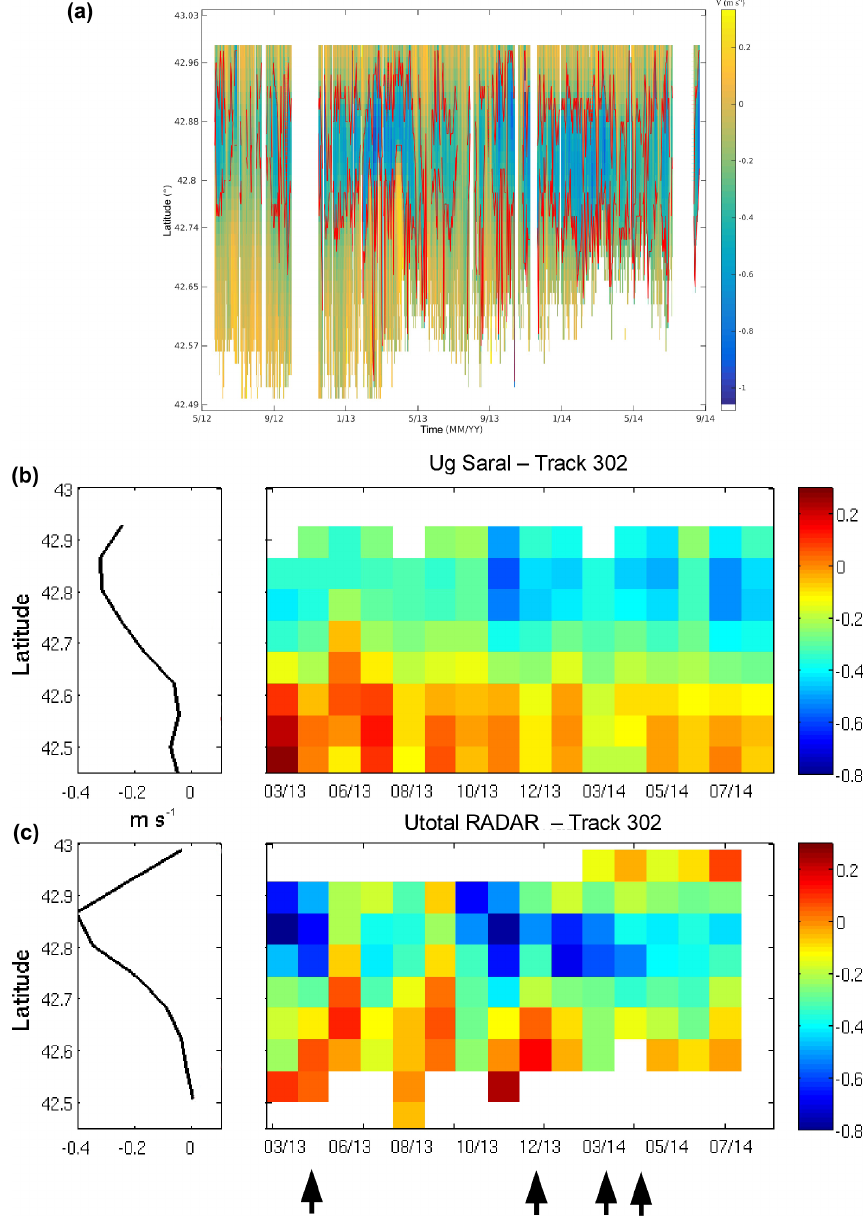
Figure 11. (a) Upper panel: 18-month time series of daily HF radar surface currents projected in the cross-track direction of the SARAL ground track. Red contours at − 0.3ms − 1 aid to delimit the westward Northern Current position. (b) Middle panel: extraction of these daily HF radar currents at the day of the SARAL observations. The temporal mean value is shown on the left. (c) Bottom panel: cross-track geostrophic currents from the SARAL altimeter data, filtered at 35km wavelength. Arrows mark the dates with low correlations